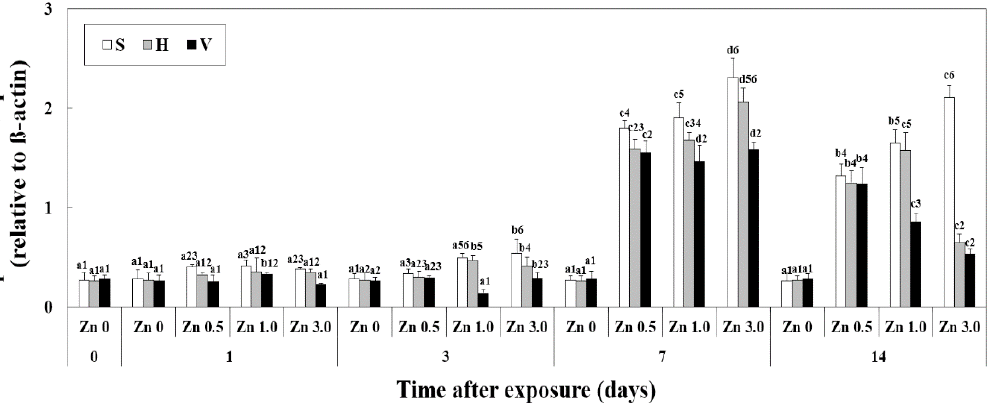
Figure 4. Changes in the mRNA expression of caspase-9 measured for 14 days. Different letters indicate significant differences among goldfish exposed to the same water hardness and different Zn concentration for same duration ( p < 0.05). Different numbers indicate significant differences among goldfish exposed to same Zn concentrations and water hardness for the different exposure time ( p <